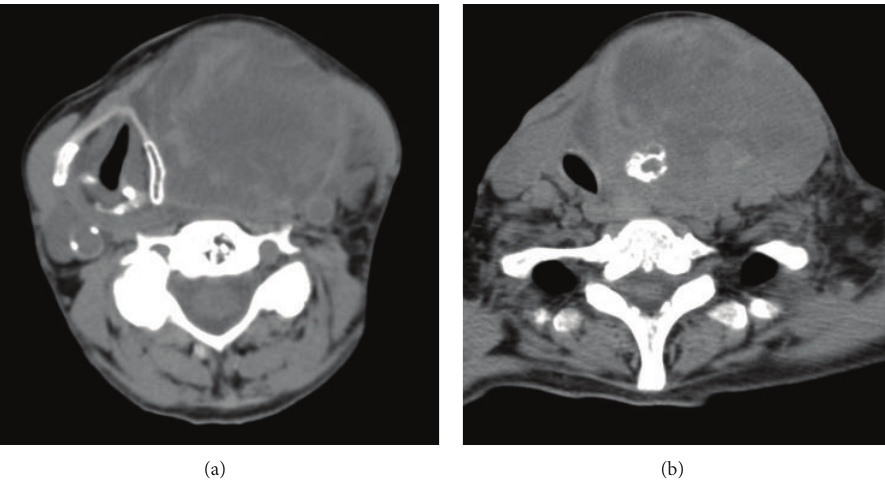
Figure 2: (a) Axial CT image showing the displacement of the larynx to the right by a heterogenous swelling on the left; (b) displacement of the trachea to the right by the lesion with internal calcification.